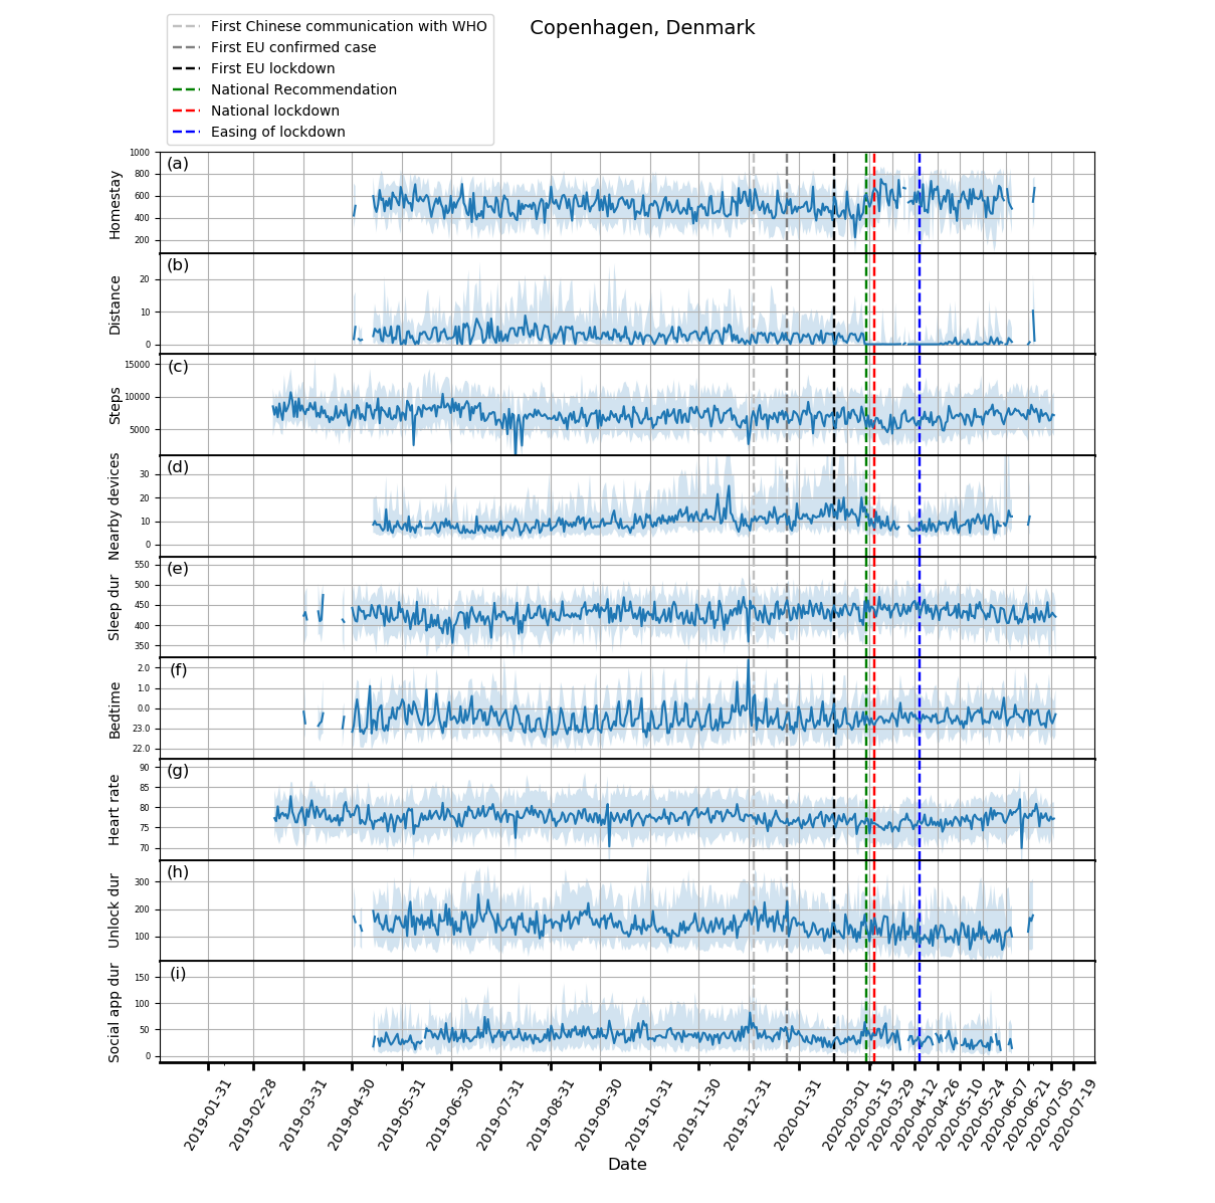
Figure 3. Behavioral changes for Copenhagen, Denmark (106 participants). (a) homestay duration, (b) maximum distance from home, (c) Fitbit step count, (d) maximum number of nearby devices, (e) total sleep duration, (f) bedtime, (g) heart rate, (h) unlock duration, (i) social app duration. Solid line: median; shade: 25th percentile to 75th percentile. dur: duration; WHO: World Health